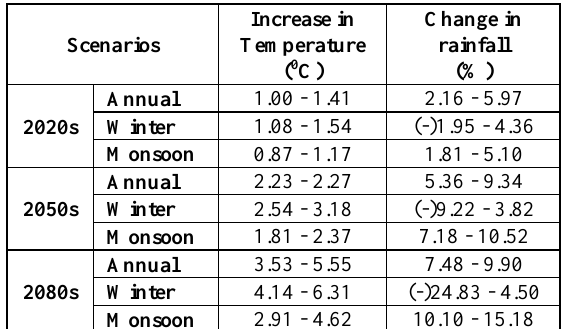
Table 1. Climate change projections for the Indian sub-